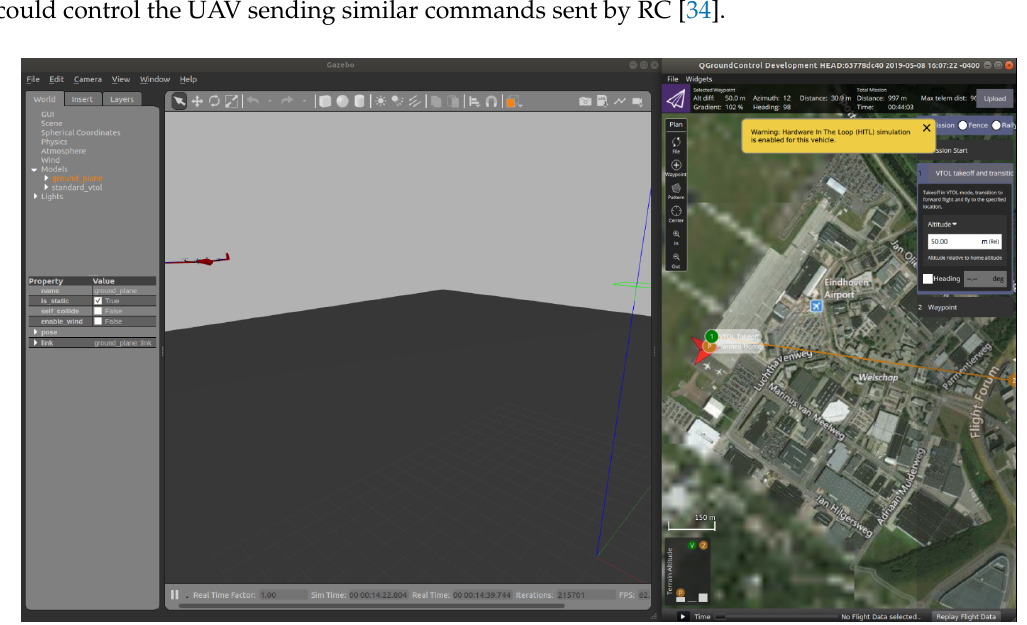
Figure 7. Hardware-in-the-loop (HITL) simulation with companion